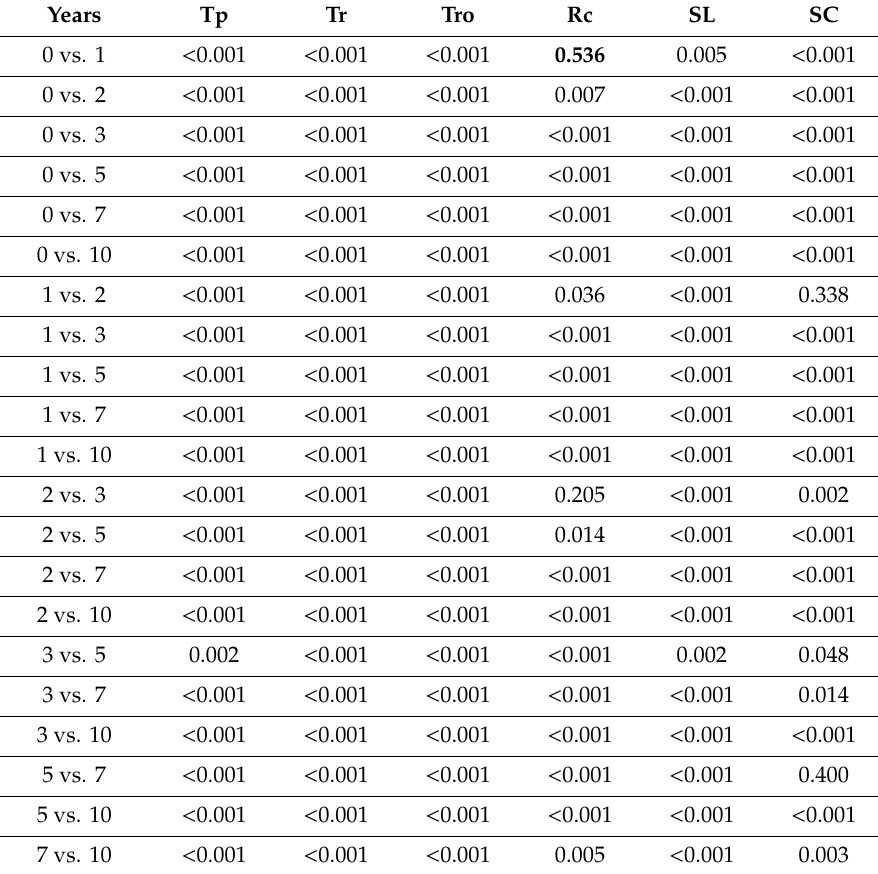
Table 1. Statistical di ff erences of hydrological responses and soil erosion results among periods of abandonment. Tp: time to ponding; Tr: time to runo ff generation; Tro: time to runo ff in outlet; Rc: runo ff coe ffi cient; SC: sediment concentration; SL: soil